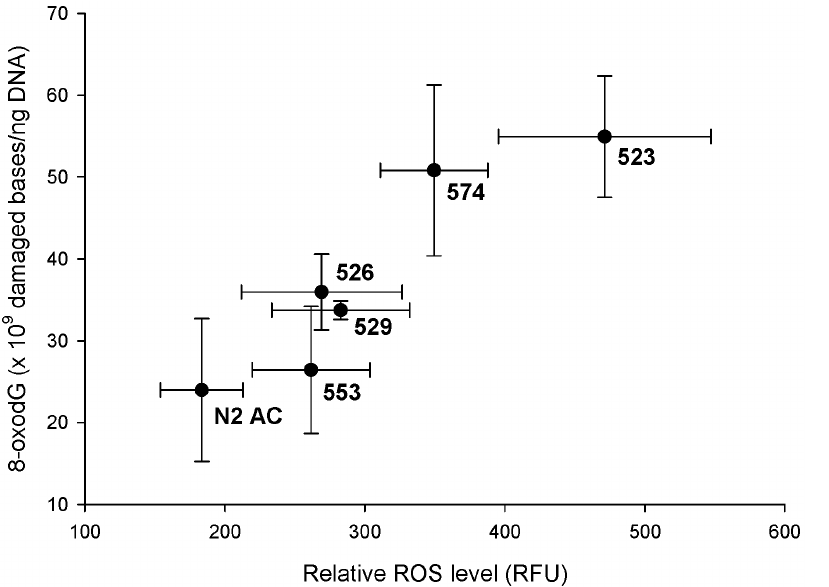
Figure 1. Bivariate relationship of line means for net invivo ROS level and 8-oxodG content. Relative reactive oxygen species (ROS) levels are reported in relative fluorescence units (RFU); quantity of 8-oxo-7,8-dihydro-2 9 -deoxyguanosine, or 8-oxodG, are reported as 6 10 9 damaged bases per nanogram of DNA. Line means of the two metrics were significantly correlated (Spearman’s r =0.943, p =0.017 with all lines present). Bars represent one standard error. ‘‘N2 AC’’ is the N2 ancestor (progenitor of MA lines, Generation 0); remaining data labels are the Baer MA line numbers.